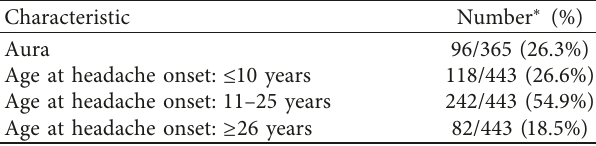
Table 1: Demographic characteristics of the migraine sample. Table 2: Aura characteristics at patient